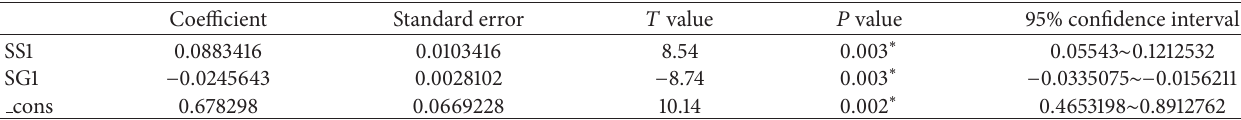
Table 3: The meta-regression results among 6 studies under the recessive genetic model for the association of Mink S38G gene polymorphism with AF in the Chinese population.